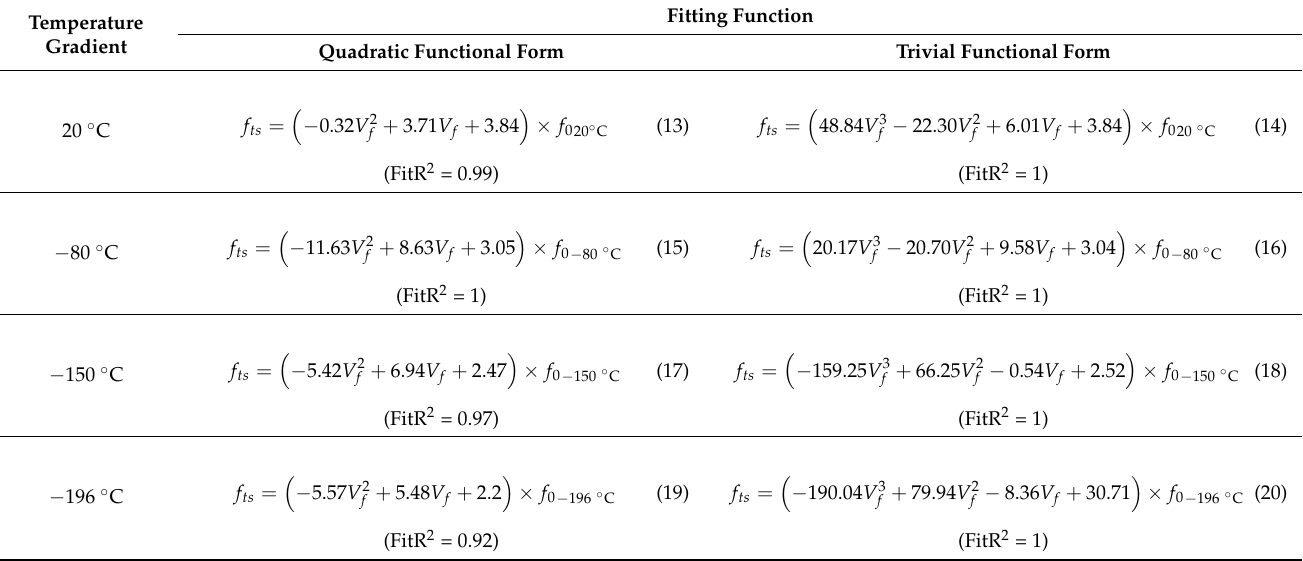
Table 6. Fitted functions of splitting tensile strength with different fiber volume fractions and different temperature